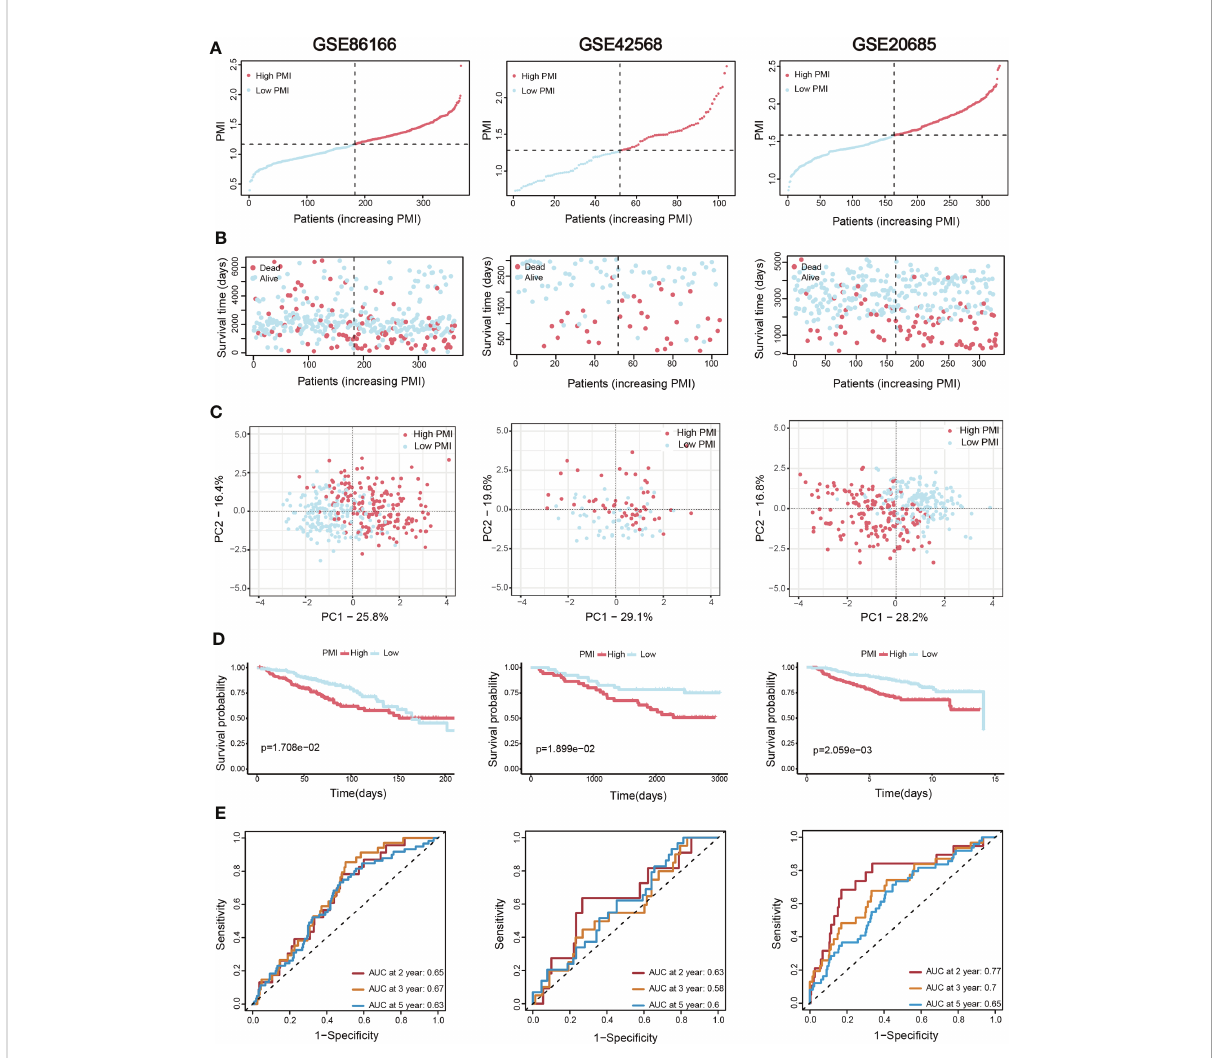
FIGURE 6 Additional three validation sets for the assessment and veri fi cation of the ef fi ciency of the PMI signature. (A) The increasing PMI score in GSE86166, GSE42568, and GSE20685. (B) Variations in the deaths of BC patients accompanied by PMI increasing. (C) The PCA analyses of high- and low-PMI clusters. (D) KM analyses of overall survival probabilities between the high- and low-PMI subgroups. (E) The ROC curves of the PMI-only model in predicting 2-, 3-, and 5-year OS of BC